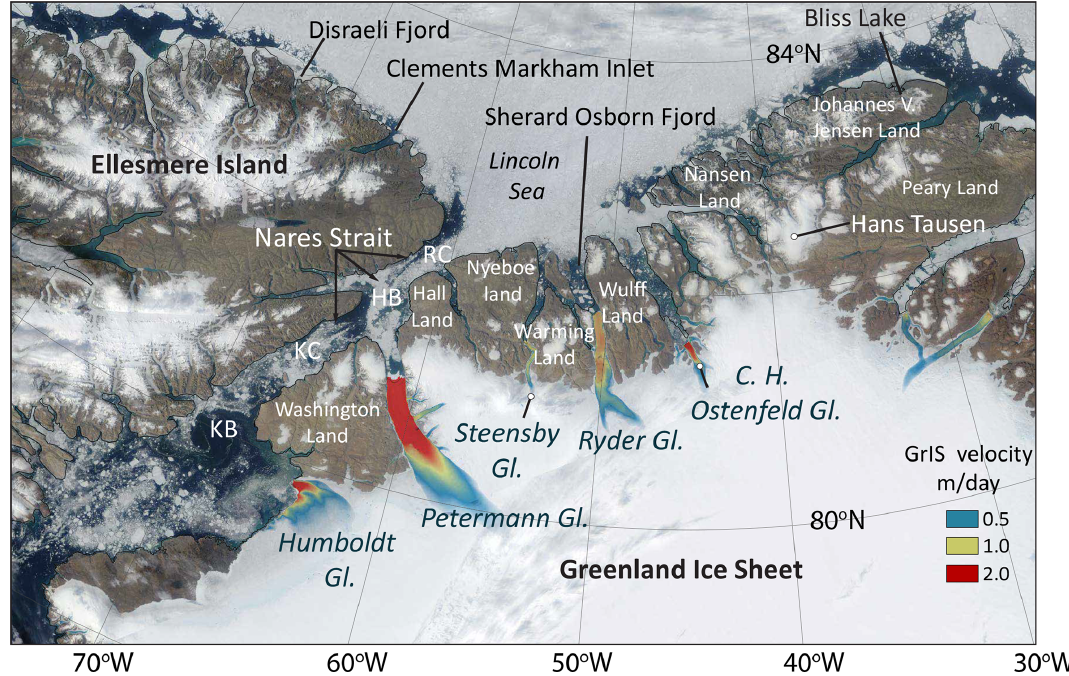
Figure 1. Satellite view of north Greenland and Ellesmere Island from 30 July 2019. Velocities of outlet glaciers are from Sentinel-1, winter campaign 2019/2020, version 1.3 (Nagler et al., 2015). Robeson Channel (RC), Hall Basin (HB), Kennedy Channel (KC), and Kane Basin